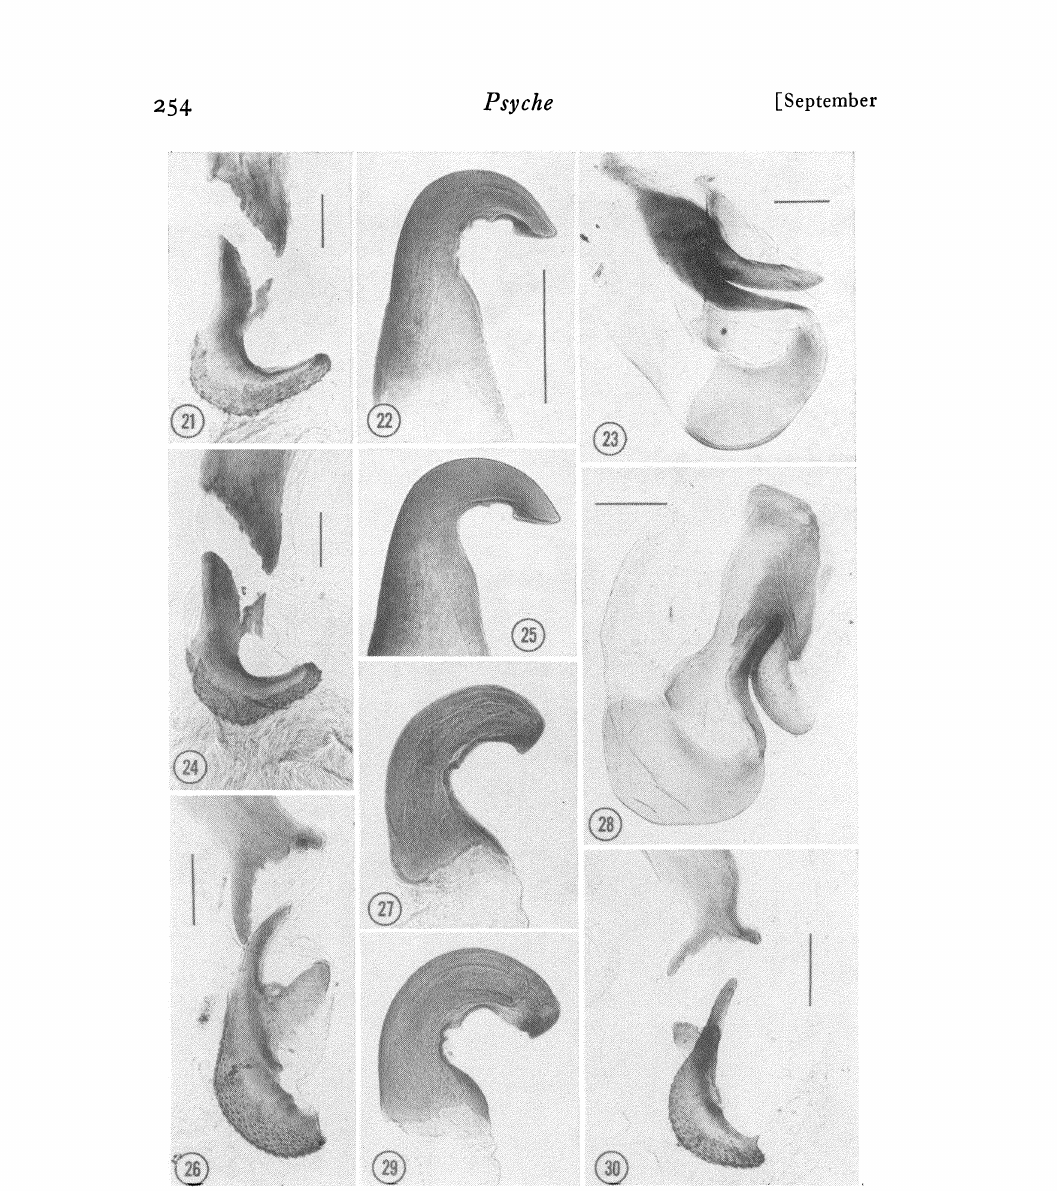
Figs. 21-30. Male genital phallomeres of Pycnoscelus spp. 21-25. P. suri- namensis. Two males which occurred in a culture originating ro.m Fraser Island, Australia. 26-30. P. semiitreus. 26-28. (102 MCZ). Manila, Philip- pine Islands (det. Princis). 29-30. (100 MCZ). From (scale 0.2 mm; figures 25, 27, 29 magnified to scale shown in fig.